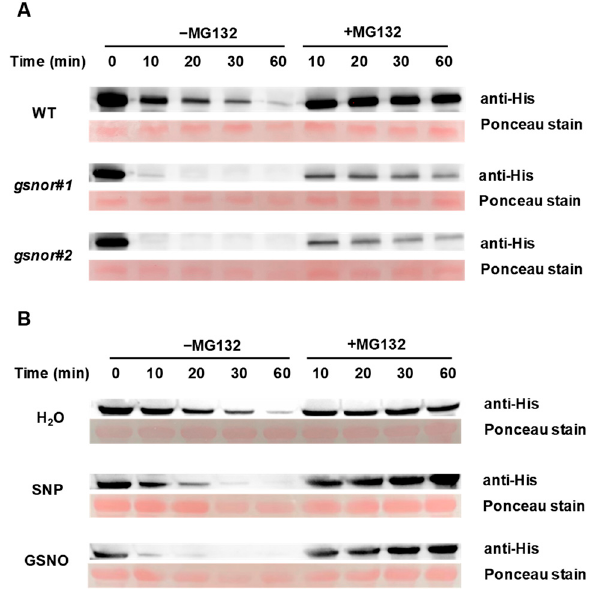
Figure 4. NO signalling promotes HY5 degradation. ( A ) Cell-free degradation assay displayed in WT, gsnor#1 , and gsnor#2 leaf extracts. ( B ) Cell-free degradation assay results displayed for H 2 O-, SNP-, and GSNO-treated leaf extracts. The degradation of His-HY5 was blocked in the presence of 50 μ M MG132 (+ MG132).